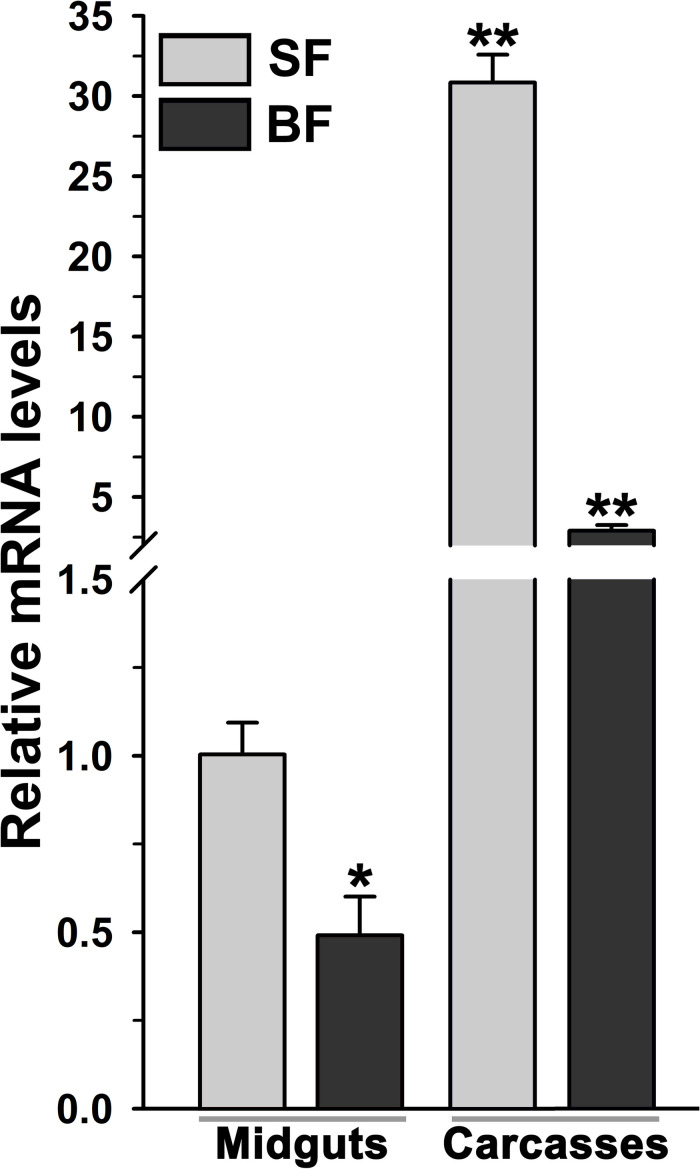
Analysis of mosquito body compartment-specific expression of AsHPX2 gene. Relative mRNA levels of AsHPX2 gene were analyzed in sugar-fed or 24 h post blood-fed mosquito midguts or carcasses. The relative levels of AsHPX2 were calculated against mRNA levels of sugar-fed midguts, which were considered as 1.0. Significant differences p < 0.01 or <0.05 are indicated by two or one asterisk, respectively.